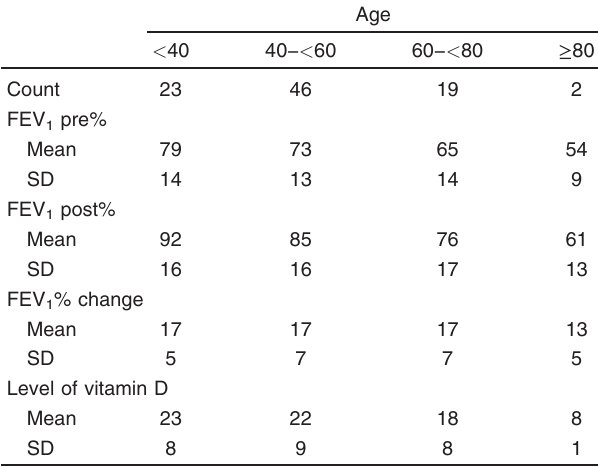
Table 2 A summary of the asthma-related variables of the patients of the study